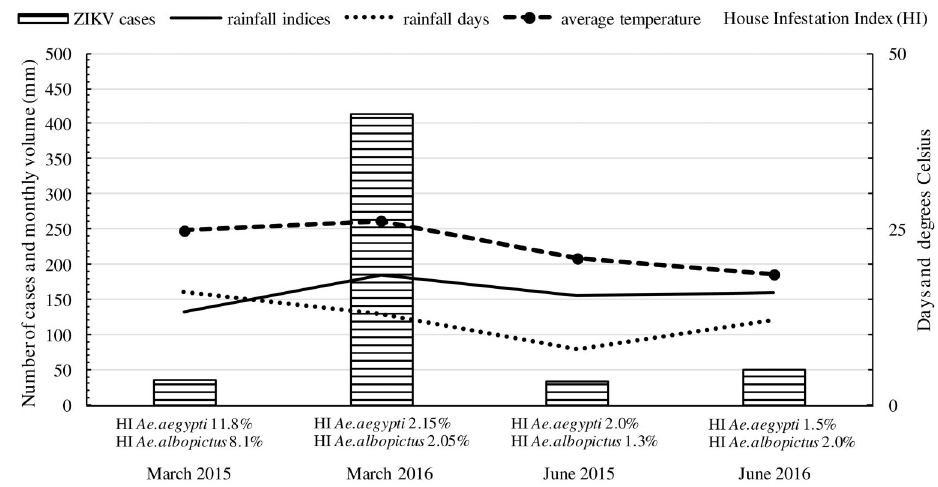
Figure 2. Relationship of number of Zika virus (ZIKV) suspected cases with rainfall and temperature data in the study months. HI: house